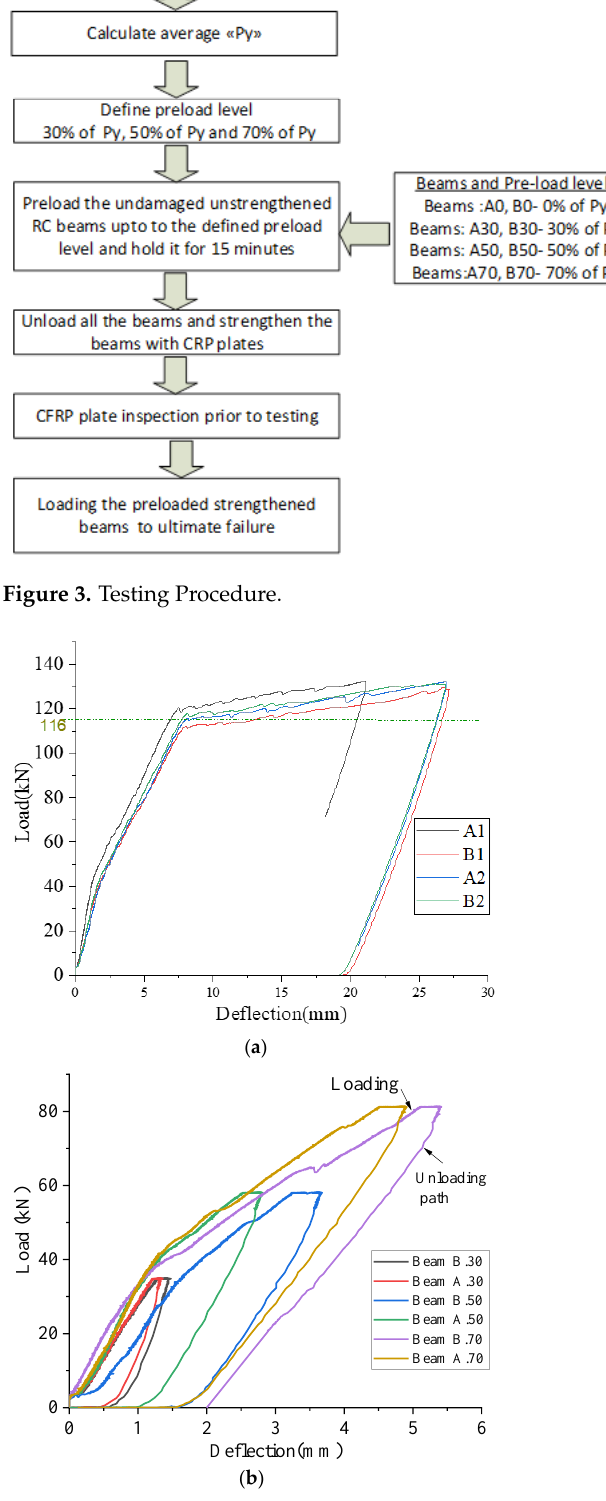
Figure 4. ( a ) Load vs. deflection behavior of un-strengthened beams, ( b ) Load vs. deflection behavior during preloading of beams.